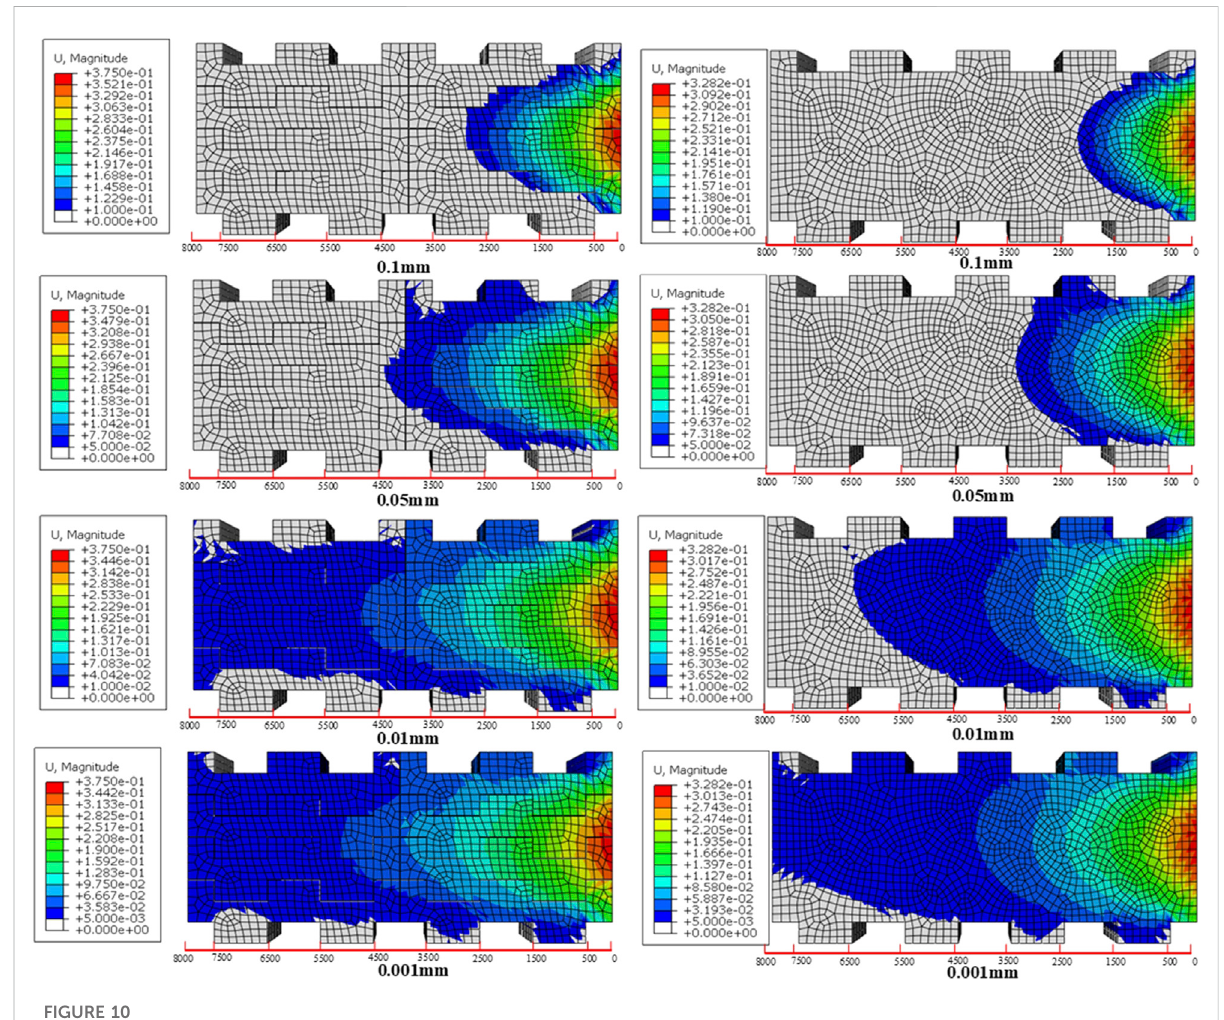
FIGURE 10 Comparison of the deformation range of the two